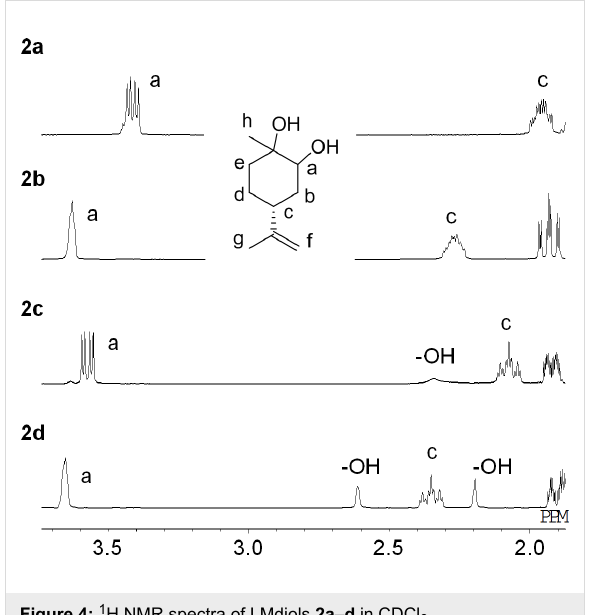
Figure 4: 1 H NMR spectra of LMdiols 2a – d in CDCl 3 .